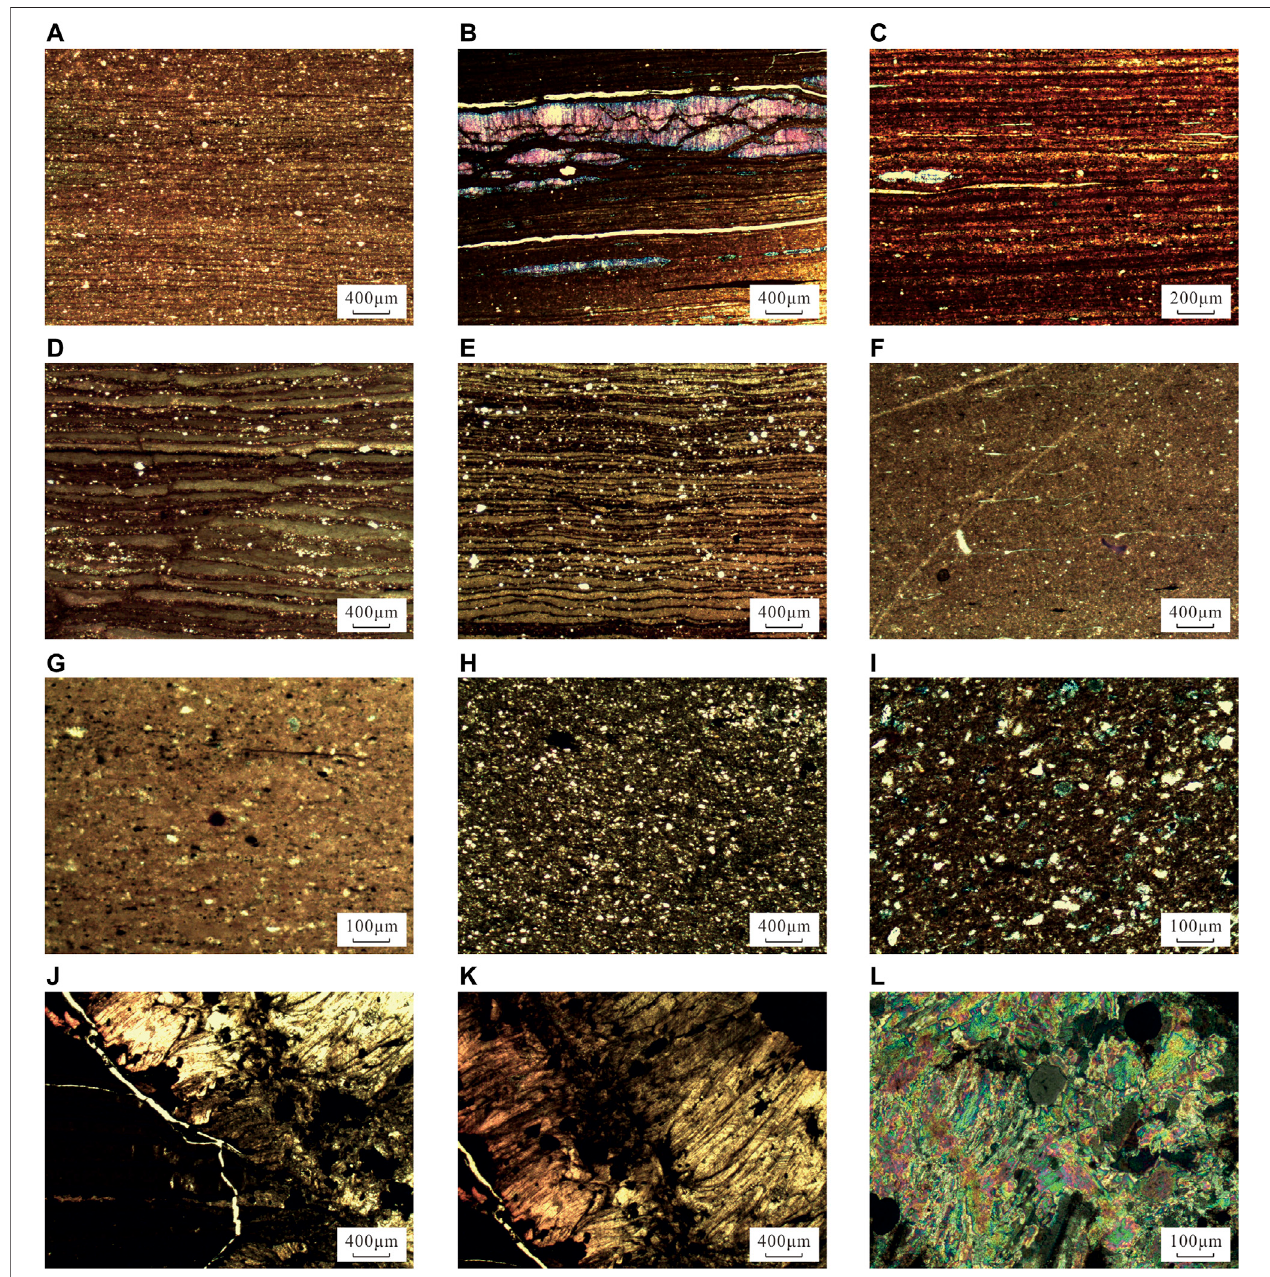
FIGURE 2 | Microscopic photographs of shale samples from the Dongying Sag. (A) Organic and argillaceous laminae interbedded in fi ne laminated shale. (B) Sparry calcite developed in fi ne laminated shale. (C) Fine laminated shale. (D) Carbonate and argillaceous laminae interbedded in wide laminated shale. The carbonate laminae were partially lenticular. (E) Organic laminae distributed in argillaceous matrixes in discontinuous laminated shale. (F) Homogenous massive mudstone mainly composed of argillaceous minerals with no obvious layers. (G) Detrital particles distributed in a dispersed manner in homogenous massive mudstone. (H) Detrital particlesdispersedinargillaceousmatrixesindetritalmassivemudstone. (I) Detritalmassivemudstone. (J) Gypsum-bearingmudstone. (K) Anhydriteveinsdevelopedin argillaceous matrixes. (L) Gypsum under orthogonal light.